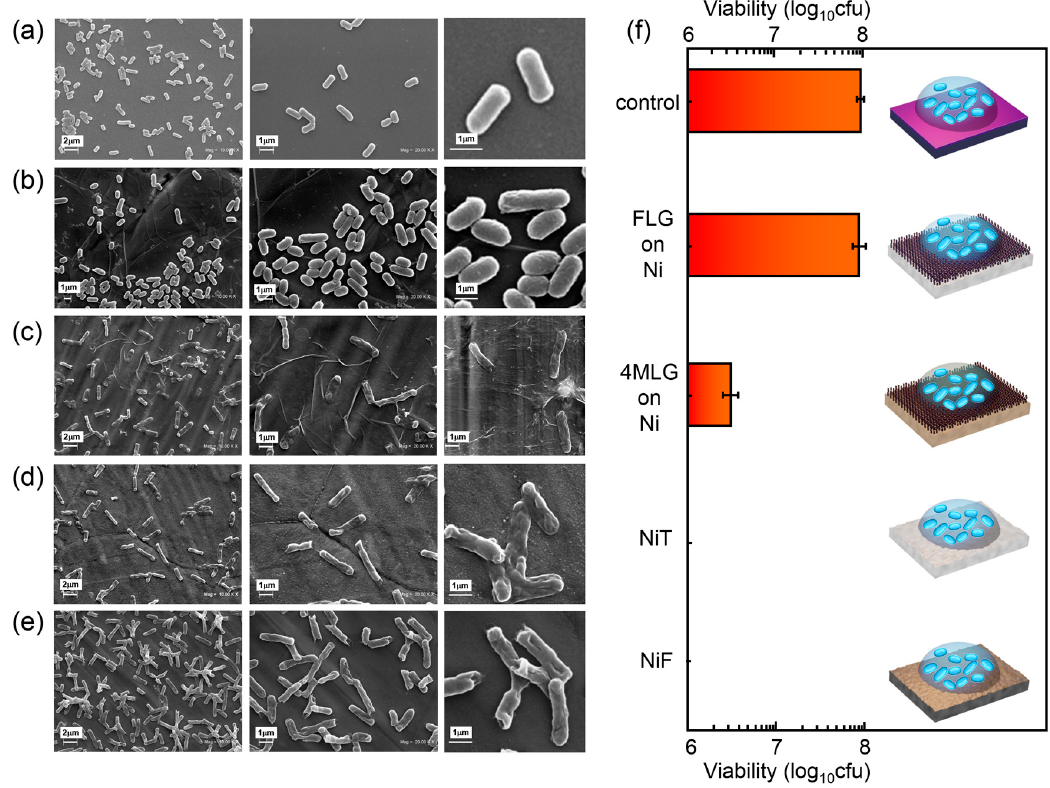
Figure 3. Biological interaction of graphene-coated Ni samples. SEM images of E. coli after 24